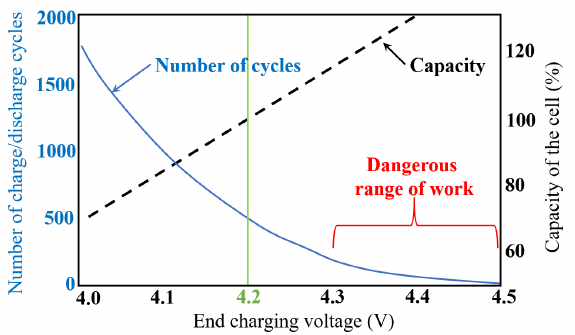
Figure 10. Dependence of service life on final charge.